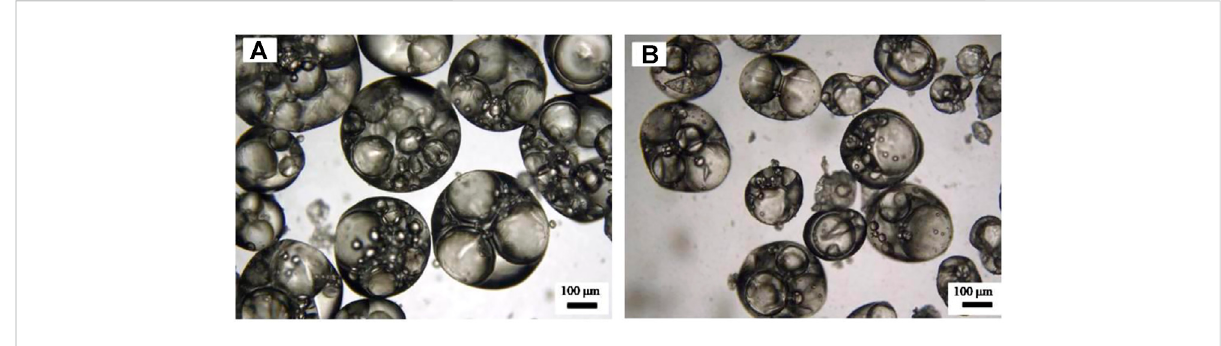
Micrograph of the water-in-toluene-in-water (W/O/W) multiple emulsions shown in Figure 10 prepared by (A) magnetic stirring and (B) homogenization, taken 24 h after preparation.